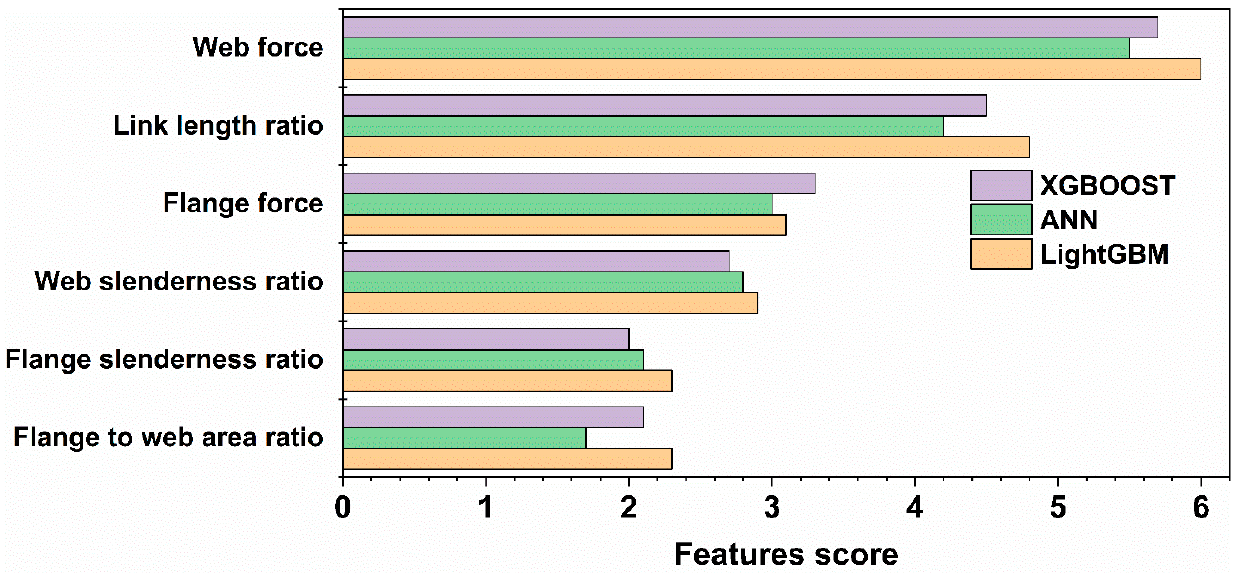
Figure 9. Representation of features importance.